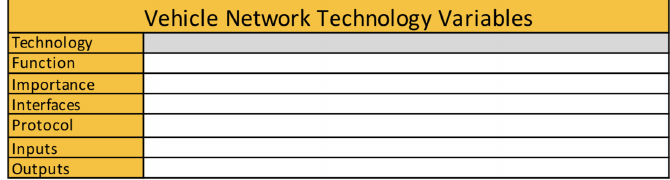
Figure 2. Phase 1 Template: Vehicle Network Technology